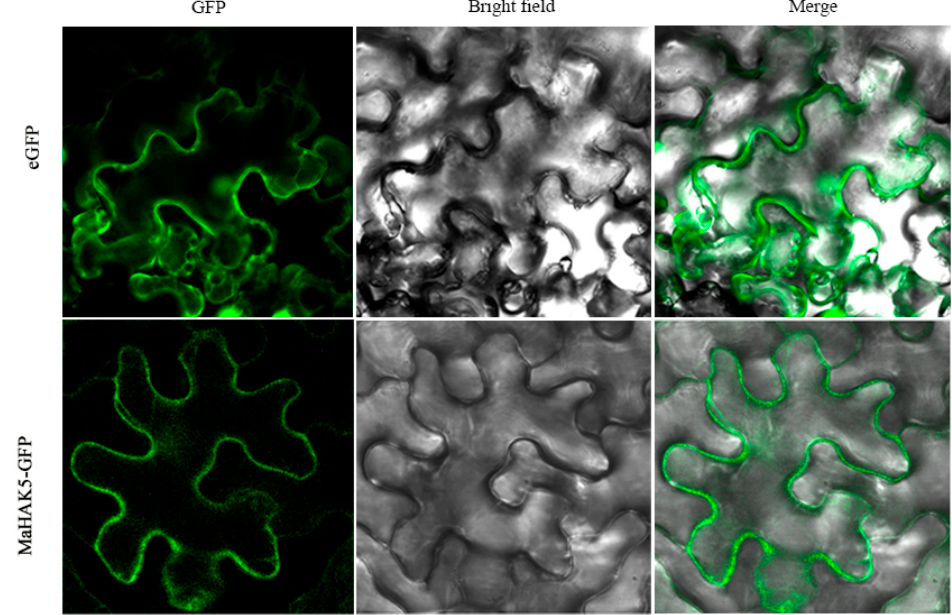
Figure 2. Subcellular localization of MaHAK5. Localization of MaHAK5 in tobacco leaves. GFP and GFP ‐ MaHAK5 were transiently expressed in tobacco leaves.